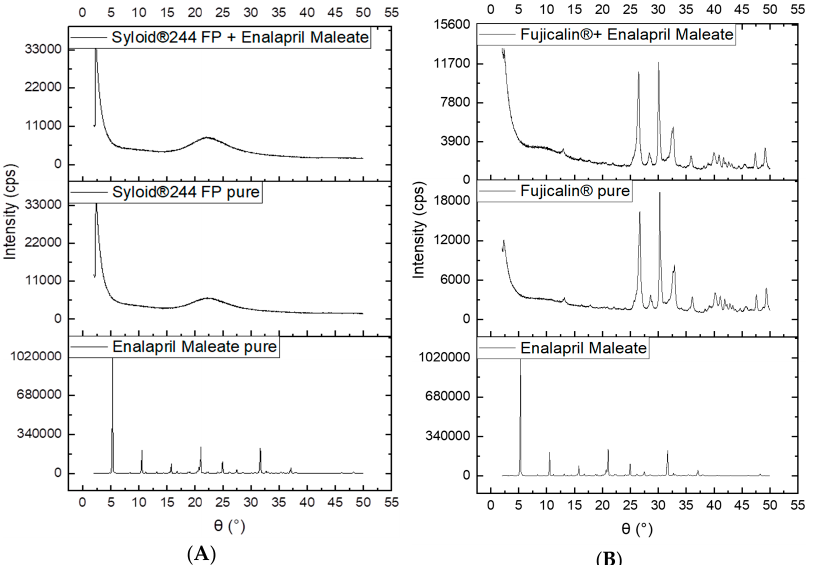
Figure 6. X-ray diffraction patterns of 1 mg enalapril maleate capsules prepared with Syloid 244 FP ( A ) and Fujicalin ( B ).